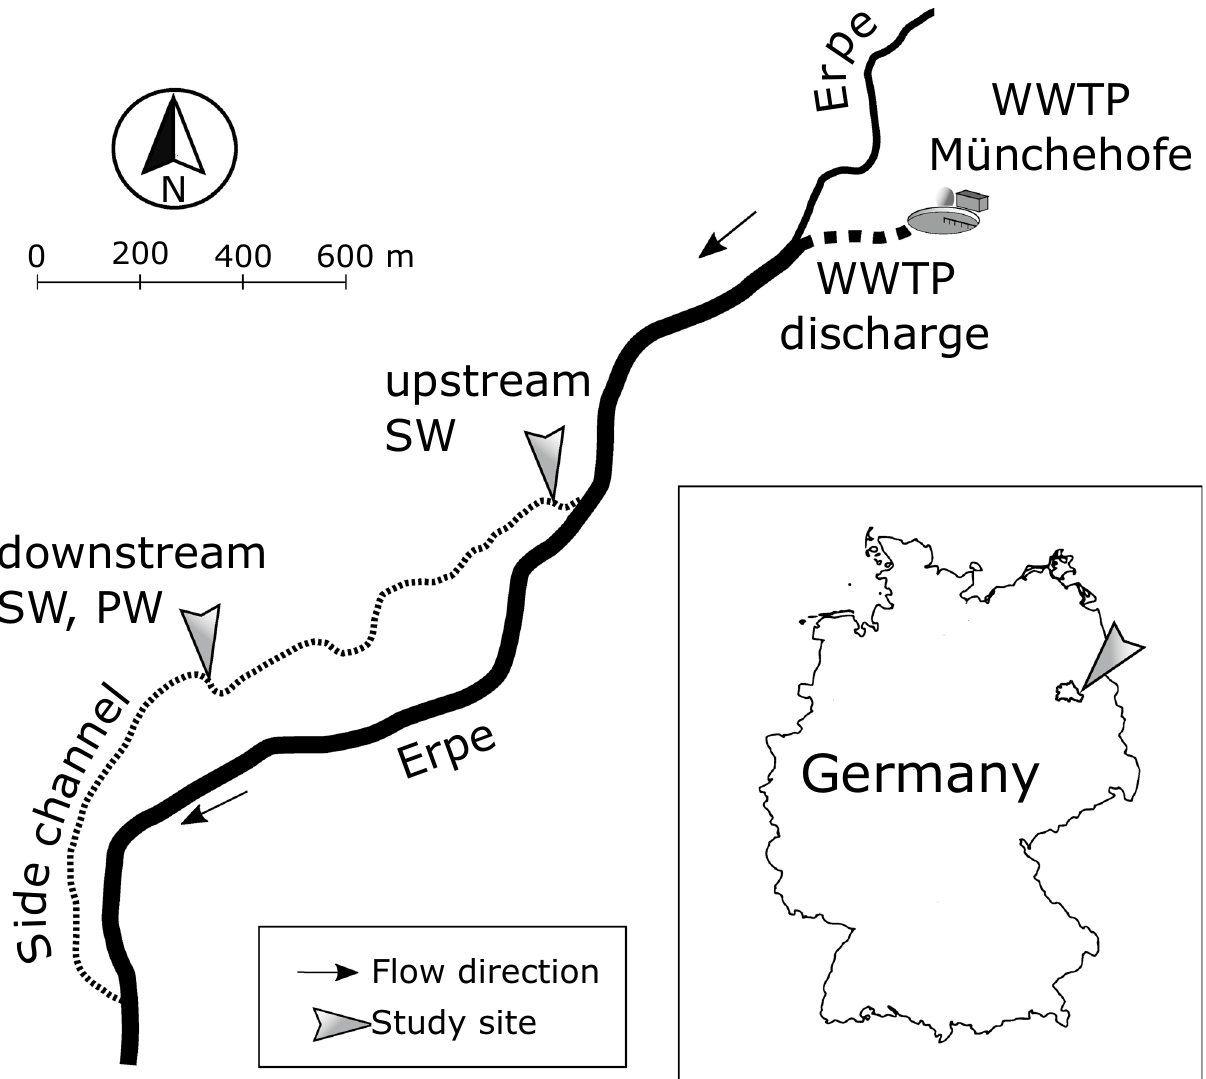
Figure 5. Map of the study site. WWTP: wastewater treatment plant. River compartments from which samples have been taken are indicated (SW: surface water, PW: pore